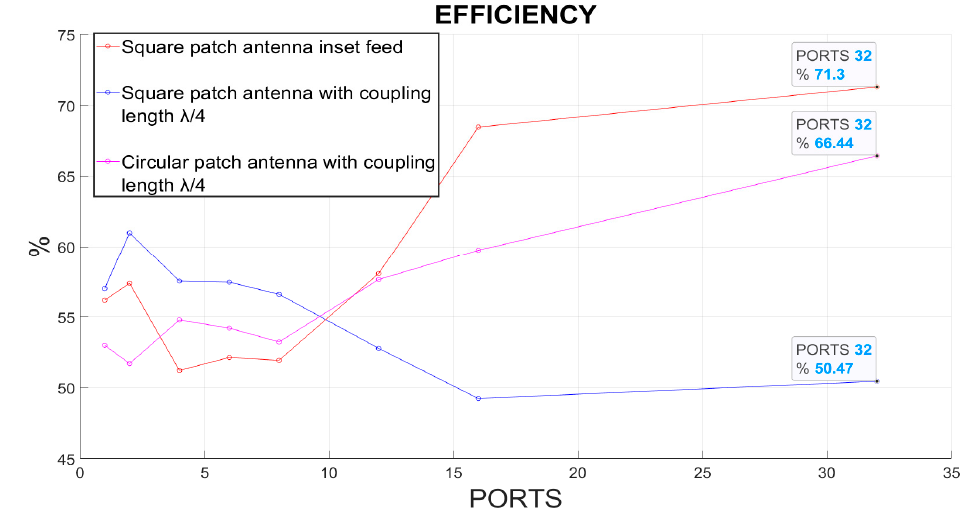
Figure 12. Efficiency of antennas containing from 1 to 32 elements.